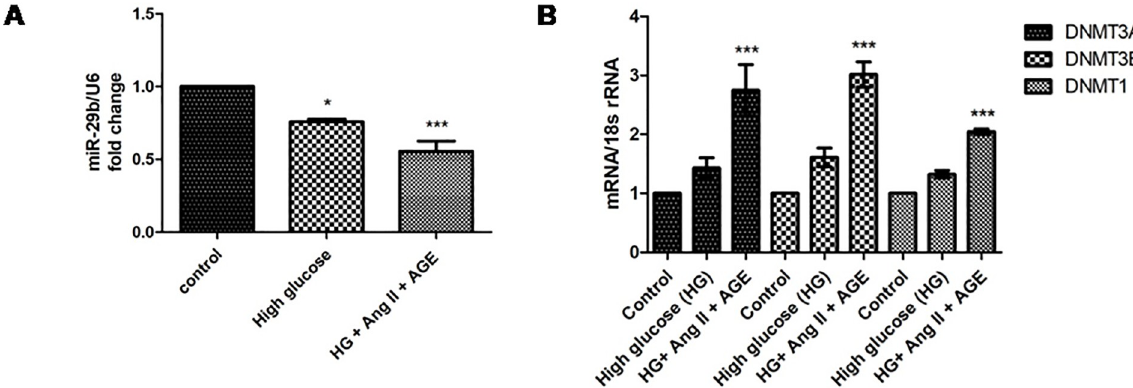
Fig 4. Effect of high glucose, angiotensin II and AGE product on expression levels of miR-29b and their targets. A . Downregulation of miR29b level in RPTECs in diabetic nephropathy model. B. Quantification of mRNA levels of DNMT3A, DNMT3B and DNMT1 in Diabetic Nephropathy model. Results are represented as mean ± S.D. (n = 3) , � p < 0.05, �� p < 0.01, ��� p < 0.001 which shows significant difference when compared with control group).